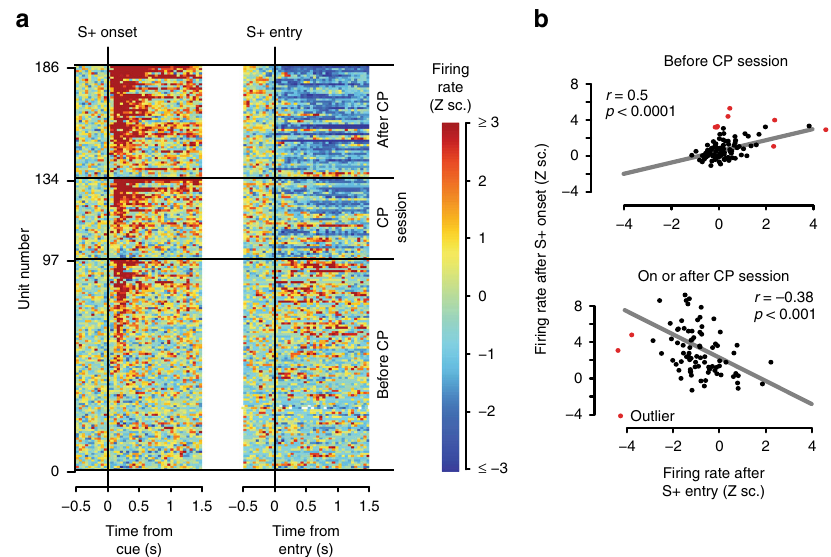
Fig. 3 After CP, NAc responses during rewarded entries switch from excitations to inhibitions. a Colors indicate average activity around S + (left) or S + entry (right) in 50 ms bins, in blocks before, during, or after change point (CP) session. Z sc.: Z scores. Neurons are sorted within each block based on the magnitude of their post-S + response. b Firing elicited by S + onset and S + entry is strongly correlated. The relationship changes from positive before CP (top) to negative after CP